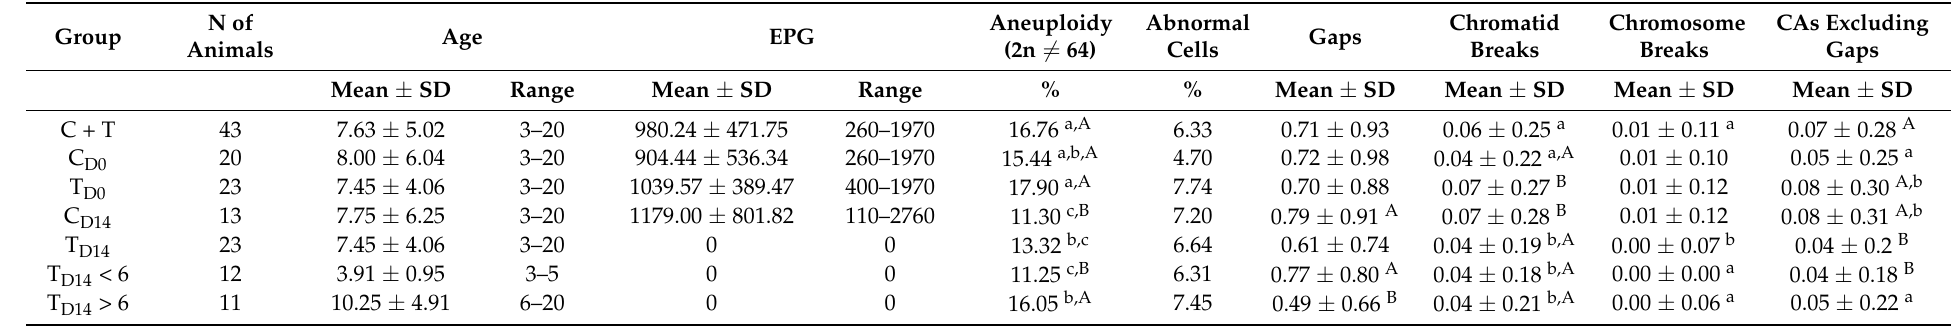
Table 1. Percentages of aneuploidy and abnormal cells and mean values and standard deviations of CA in groups C + T (all animals before the treatment), C D0 (untreated animals at T0), T D0 (treated animals before the treatment), C D14 (untreated animals at T14), T D14 (treated animals at T14), T D14 < 6 (treated animals at T14 up to 6 years), and T D14 > 6 (treated animals at T14 older than 6 years).